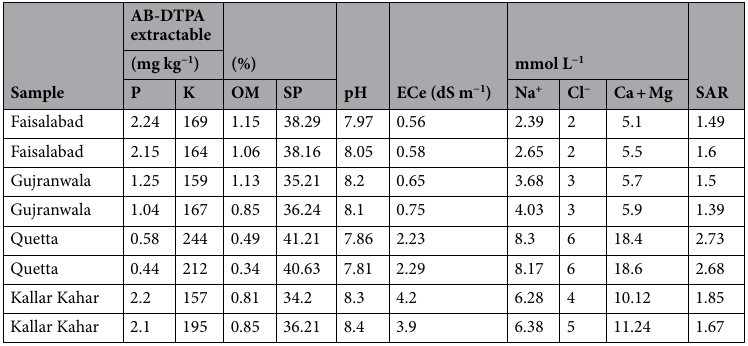
Table 2. Physio-chemical analysis of the soil of experimental site. OM organic matter, SP soluble